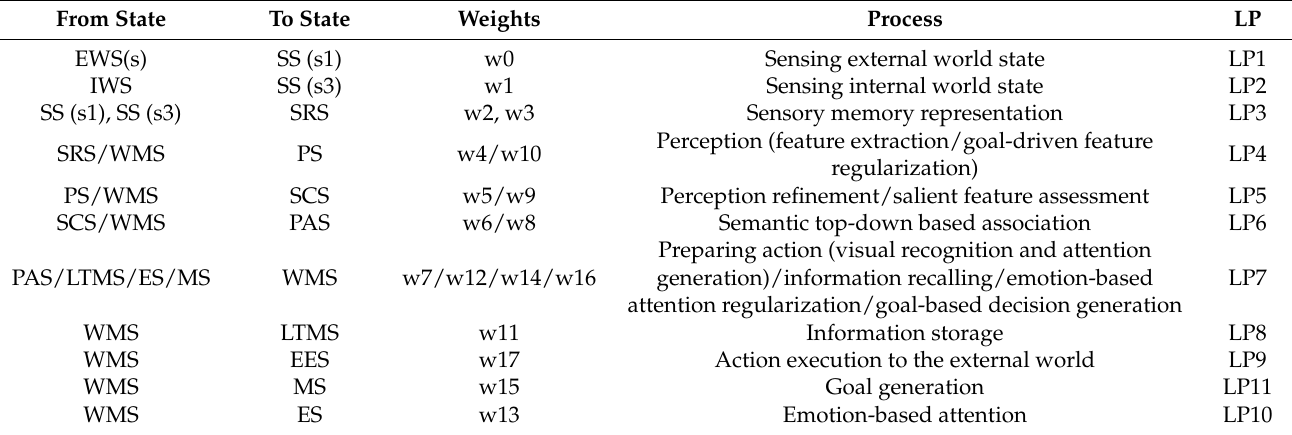
Figure 2. Functional flow of PSA. This figure defines the PSA model’s working flow by defining the different states of PSA in the light of formal methods. This figure also represents state switching of PSA on different conditional stages. Table 3. This table defines the overall working of different internal and external states of Figure